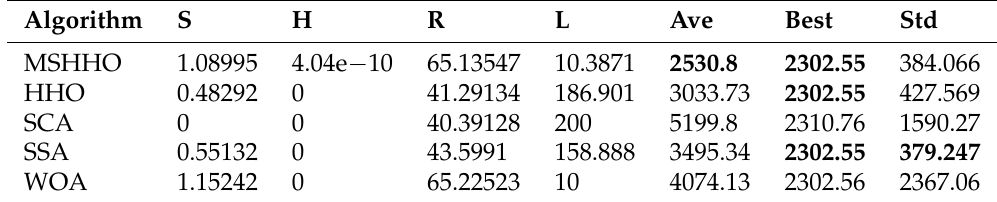
Table 9. Results of pressure vessel design problem for different algorithms.